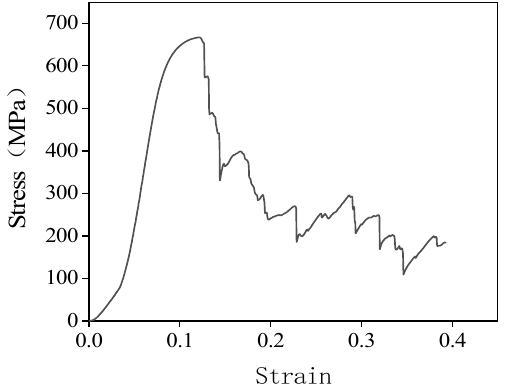
Figure 1. D structure specimen.